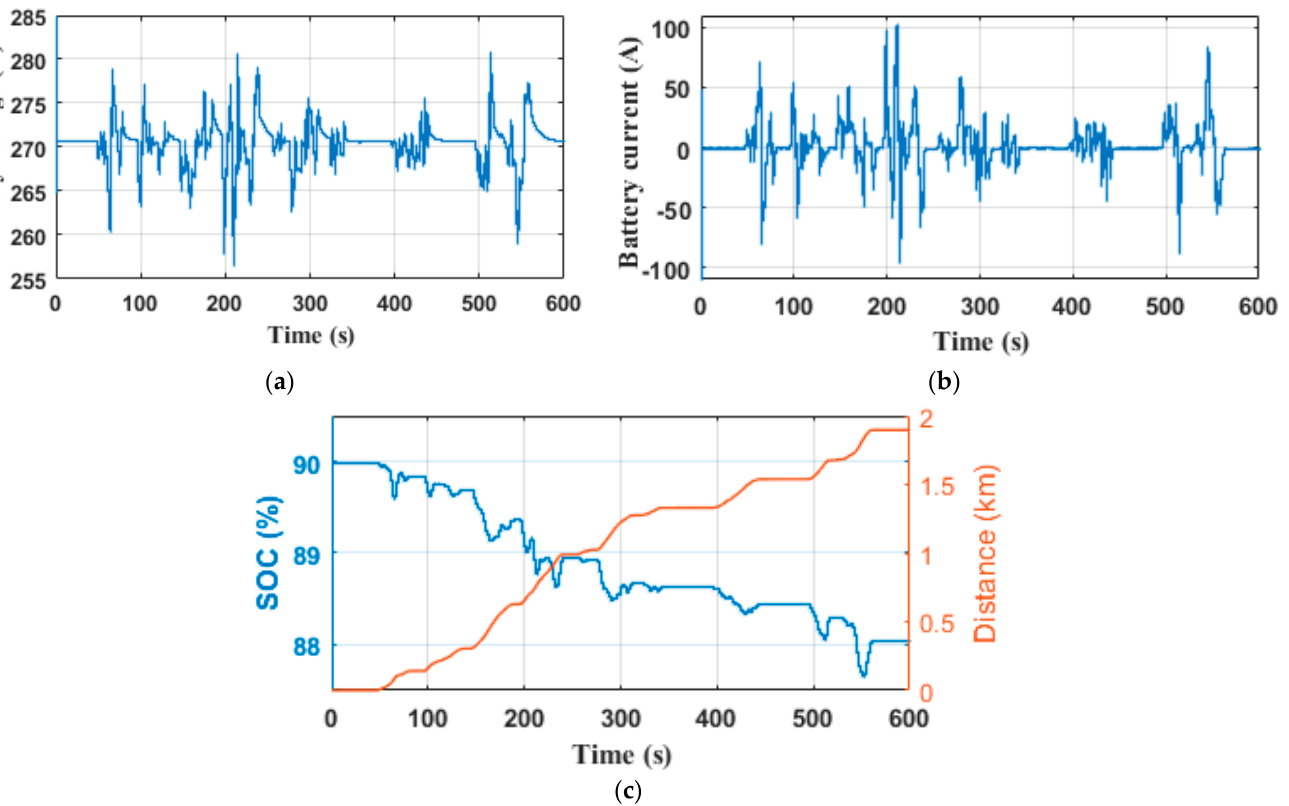
Figure 21. Li-ion battery performance with DTC technique ( a ) voltage; ( b ) current; ( c ) state of charge, and covered distance.